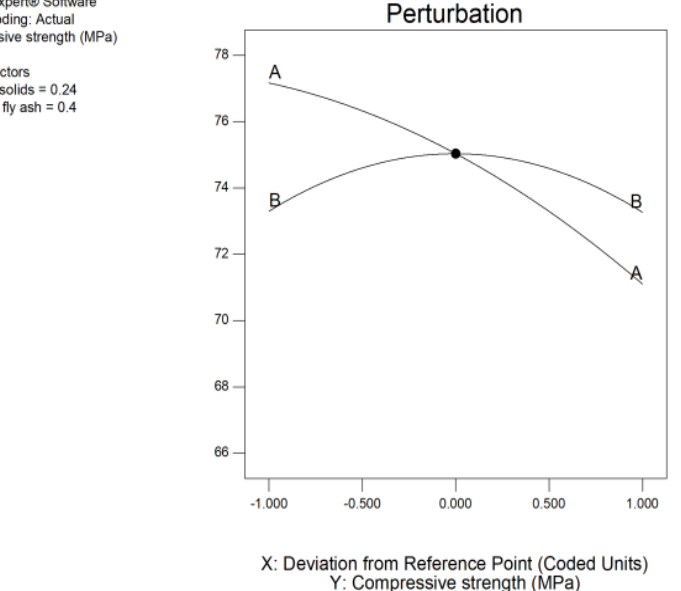
Figure 14. Perturbation curves for compressive strength of EGC .